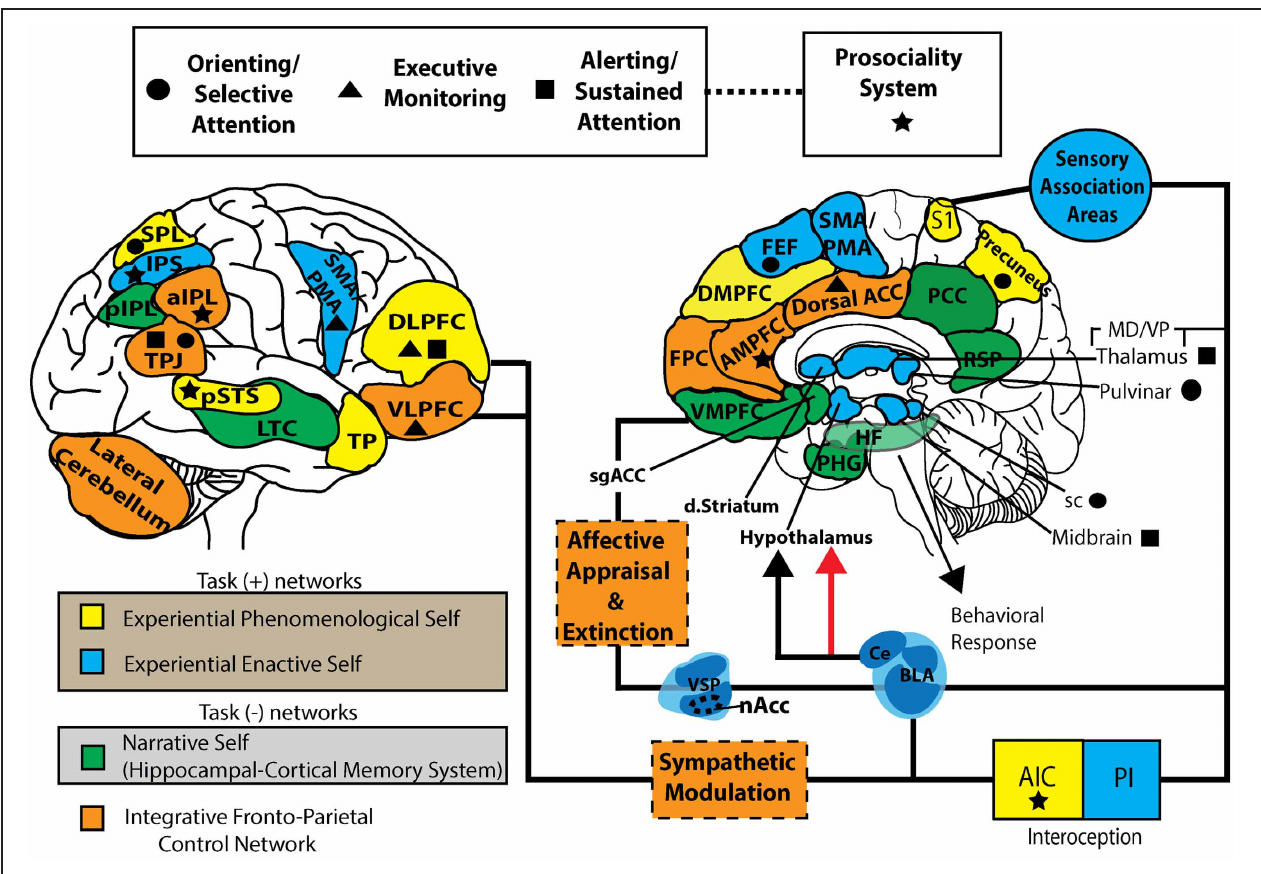
FIGURE 2 | Self-networks and neurocognitive systems supporting S-ART. This working model represents a parcellation of task positive (self-specifying: EPS and EES), task negative (NS), and integrative fronto-parietal control networks. It also represents the individual components of the attentional systems and prosociality network purported to be modulated by mindfulness. The substrates for six component mechanisms of mindfulness within a framework of S-ART are also represented. EPS, experiential phenomenological self; EES, experiential enactive self; NS, narrative self; FPCN, fronto-parietal control network; FEF, frontal eye fields; DMPFC, dorsal-medial prefrontal cortex; AMPFC, anterior medial prefrontal cortex; VMPFC, ventromedial prefrontal cortex;